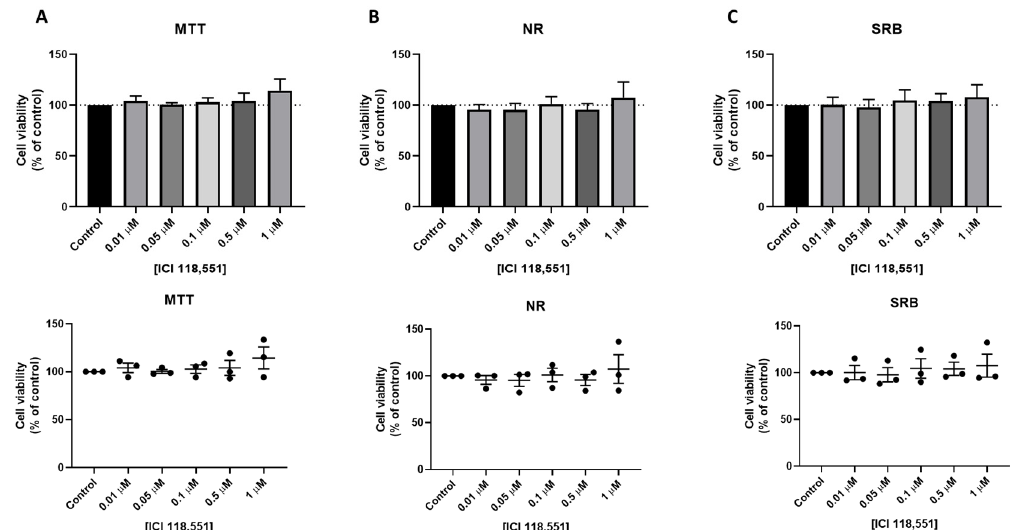
Figure 6. Effects of ICI 118,551 on the viability of MCF-7 cells determined by ( A ) MTT, ( B ) NR, and ( C ) SRB assays. Cells were treated with increasing concentrations of ICI 118,551 for 24 h. The results are shown as the percentage of control and are expressed as the mean ± SD of three independent experiments.